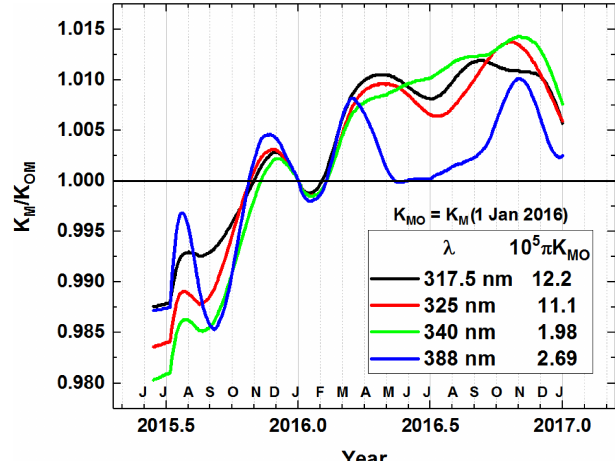
Figure 2. Normalized calibration functions referenced to its value at 4 January 2016 when D E = 1AU. Average rate of increase is 0.016 per